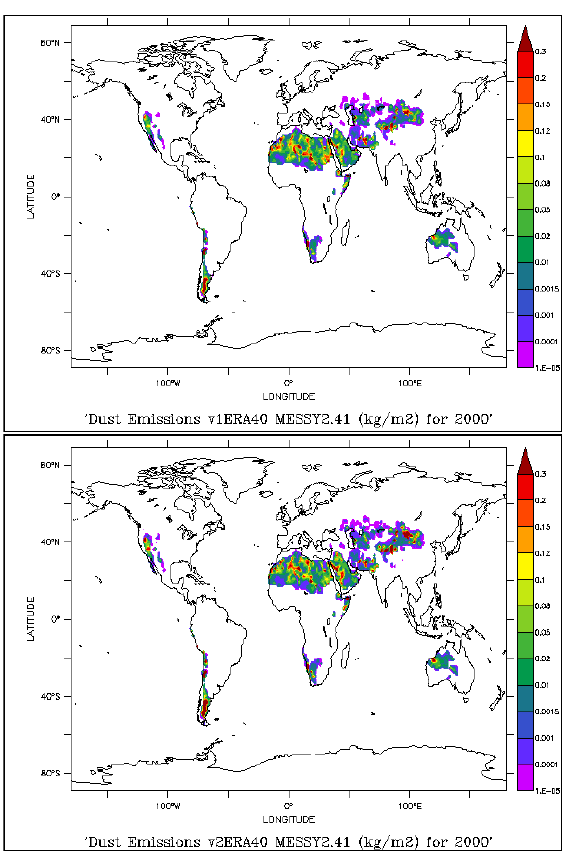
Fig. 4. Annual dust emissions (kg m − 2 ) for the year 2000: using the nudged mode with DU1 (upper plot) and DU2 (lower plot) schemes.